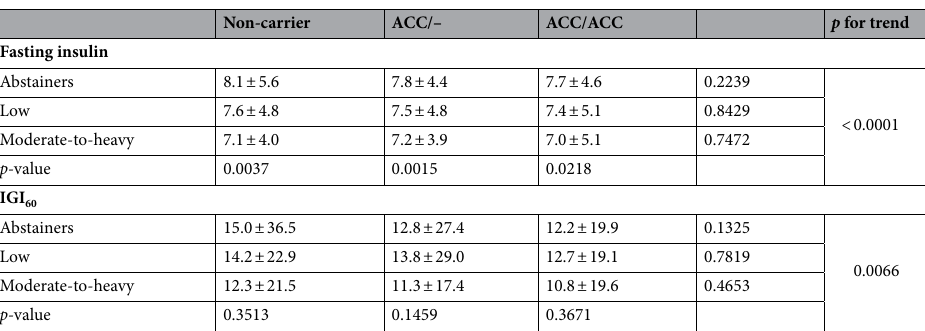
Table 4. Changes in the fasting insulin level and β-cell function according to the KCNQ1 haplotype and alcohol consumption in the Ansung–Ansan cohort. Data are expressed as the mean ± standard deviation. IGI 60 insulinogenic index at 1 h after the oral glucose tolerance test. The participants with T2DM were excluded in cohort panel. Differences in the association between the KCNQ1 haplotype and alcohol consumption were assessed by one-way